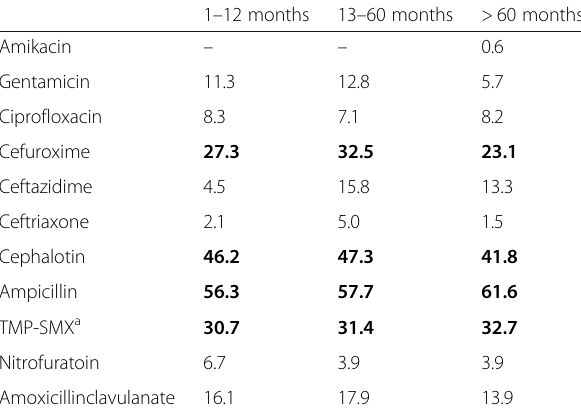
Table 2 Percentage of E. coli and various drug resistance rates against E. coli according to age